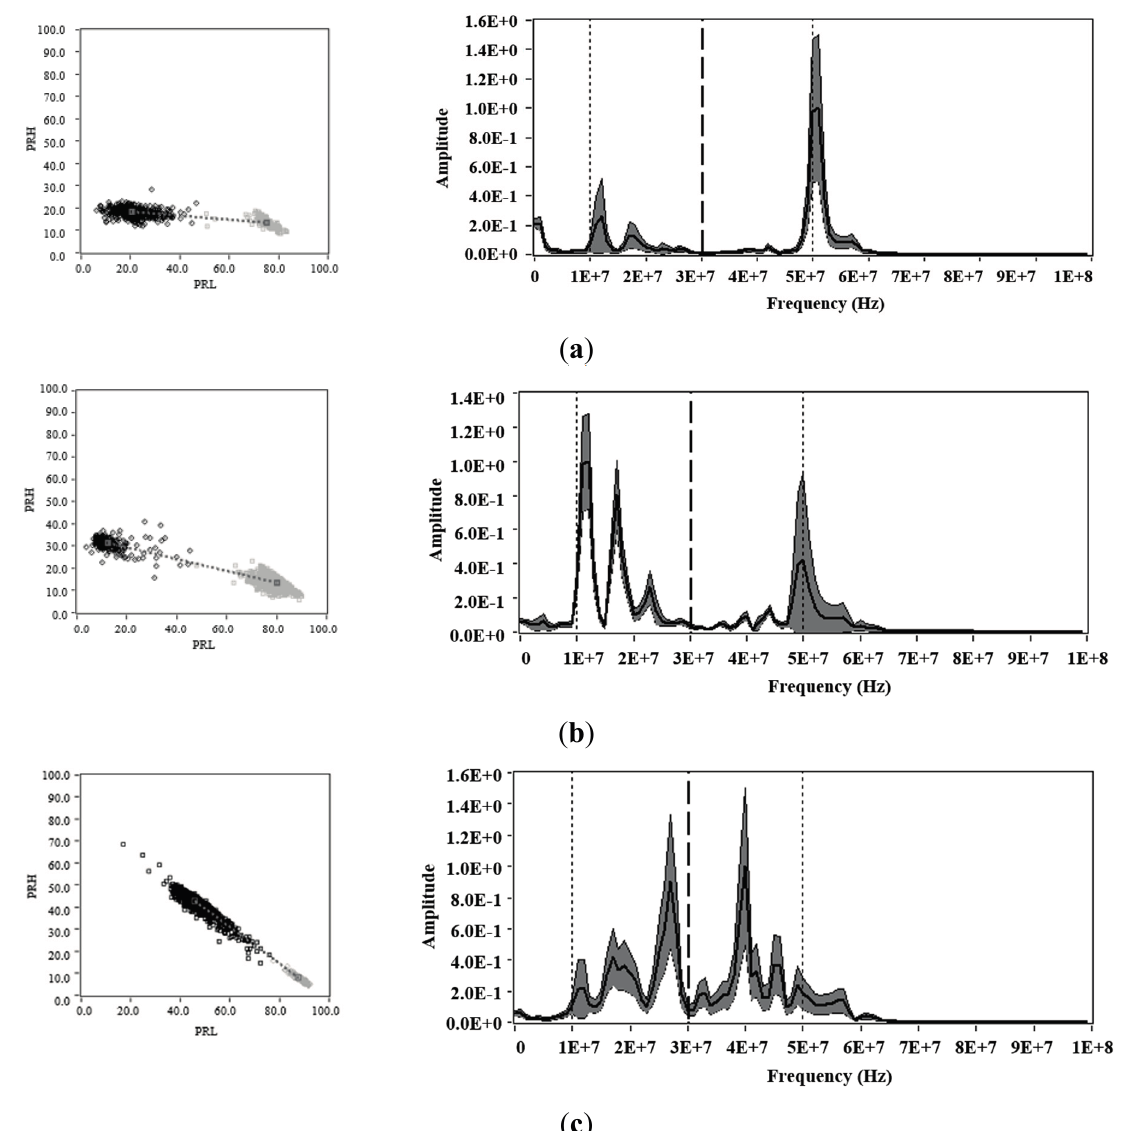
Figure 8. Power ratio maps for PD (black cluster) and noise (grey cluster), left : Average power spectrum densities, right : Obtained for ( a ) corona PD and noise; ( b ) surface PD and noise and; ( c ) internal PD and